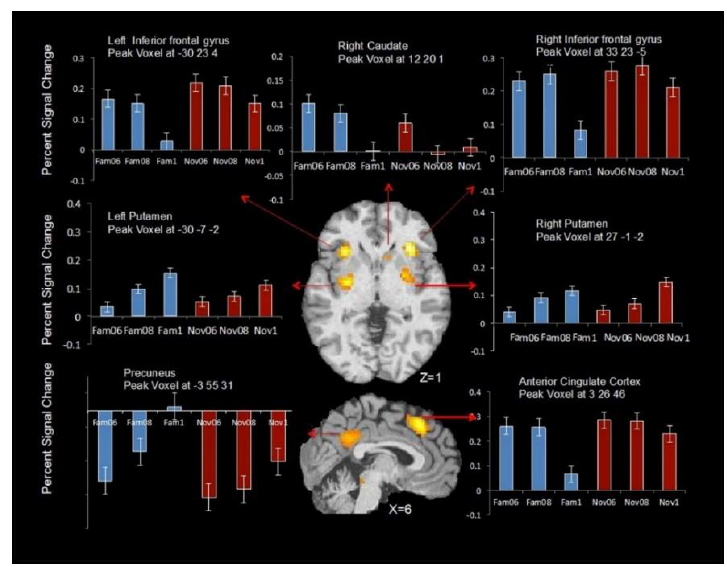
Figure 4. Areas in the bilateral putamen, bilateral inferior frontal gyrus, right caudate, precuneus, and anterior cingulate cortex showing uncertainty-related activity for CS regardless of whether the stimulus is novel or familiar ( p < 0.001, a minimum cluster size ( k ) = 10 voxels). Post hoc analysis of the probability × stimulus type interaction revealed a large cluster in the right anterior cingulate, including brodmann area (BA) 32, extending into medial frontal cortex ( p < 0.001, uncorrected) (Figure 5). This interaction effect was due to significant activations above baseline for all conditions except for the certain condition (probability = 1:0) for the familiar stimuli.